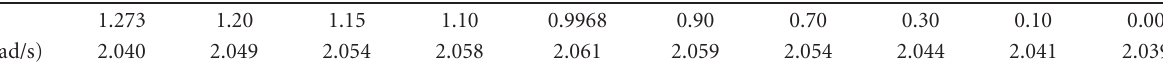
Figure 12: (a) Root loci analyses of limit cycles of Example 2. (b) ω max versus N 3 ( a 3 ) of Example 2. Table 4: The maximal frequency point ω max of each constant- N 3 ( a 3 ) locus of Example 2.